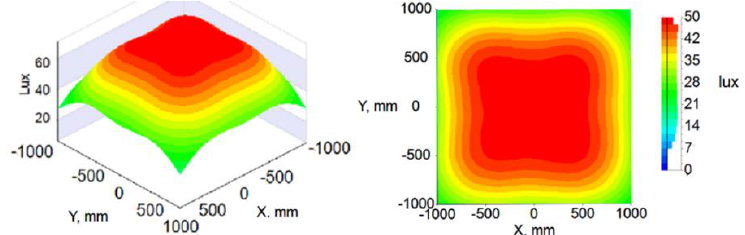
Figure 8. Light distribution on an LED receiver using a collimator and double linear Fresnel lenses.